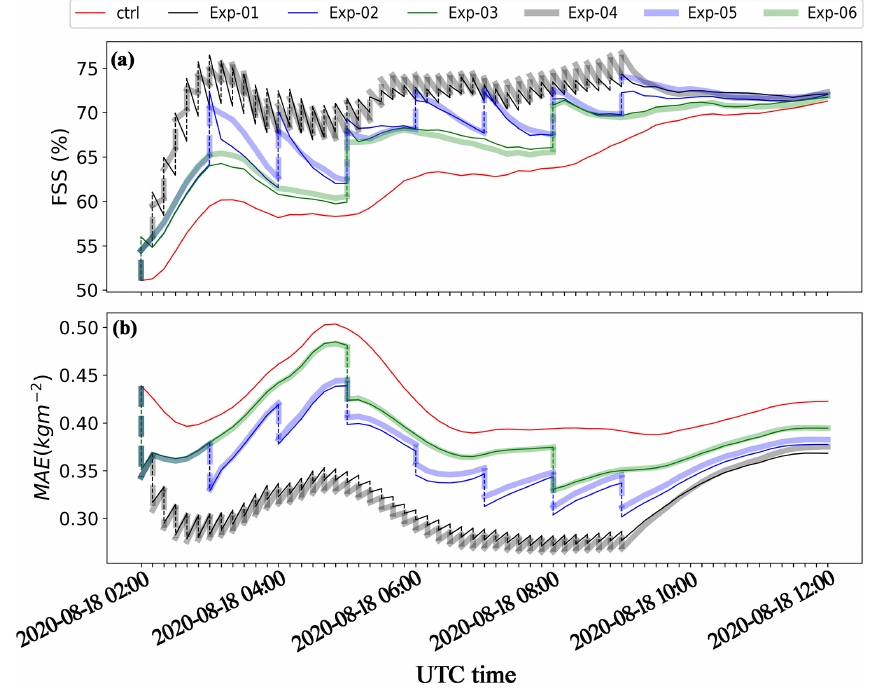
Figure 9. Time evolution of (a) FSS and (b) MAE of the ensemble mean of the first-guess forecast and analysis of CWP for the cycled DA experiments which are designed to illustrate the sensitivity to filter